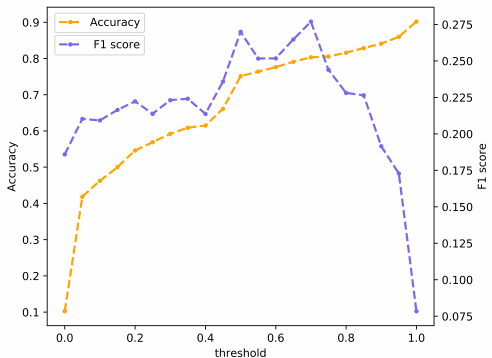
Figure 8. The performance of our method in geoeffectiveness prediction with different thresholds on the testing